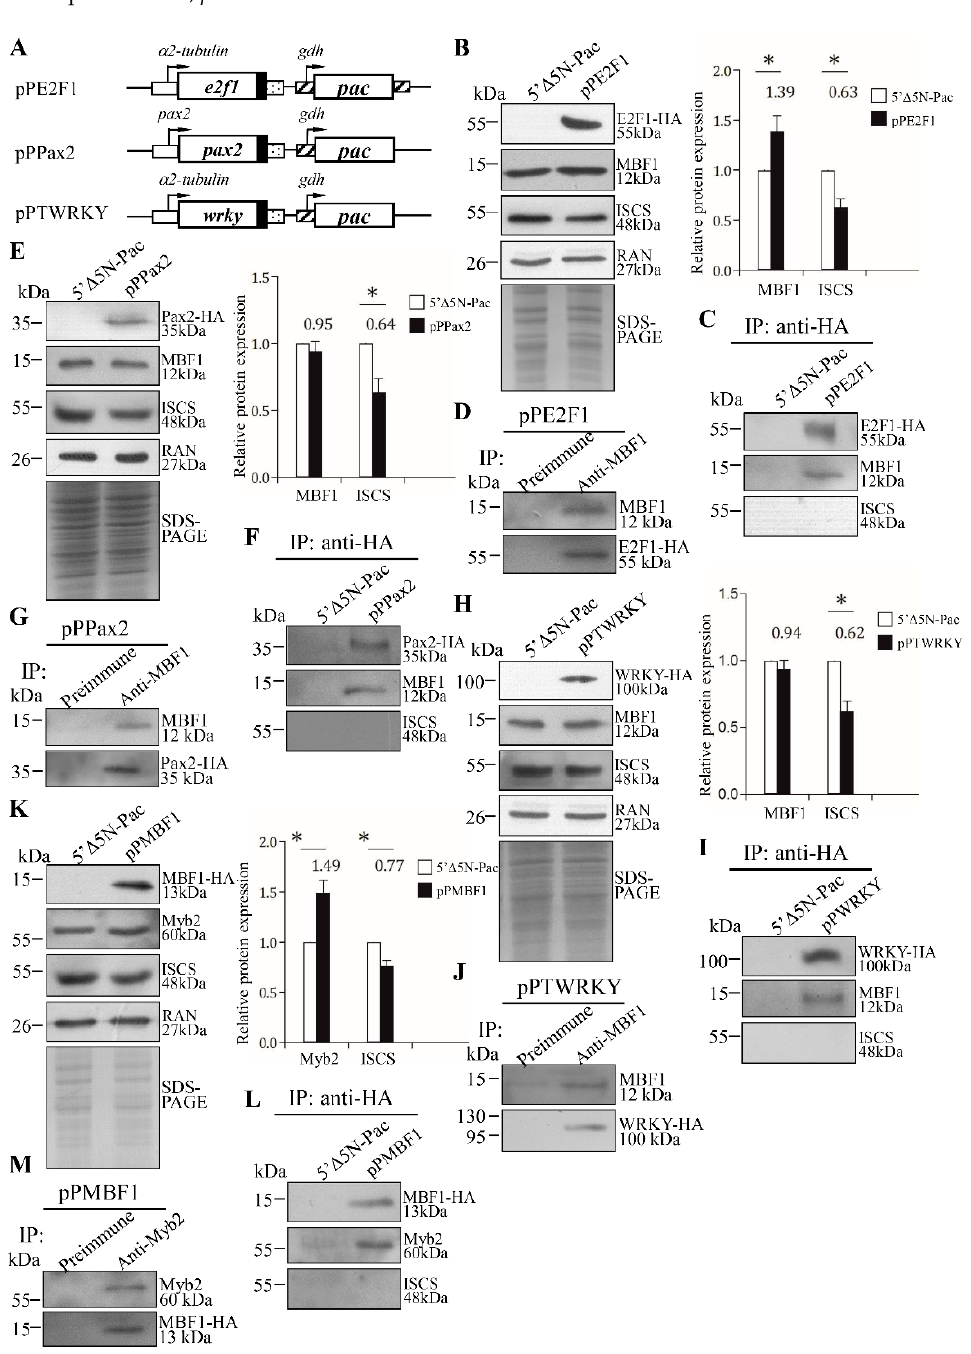
promoter fragments (+), but not the U6 promoter fragment ( − ). The 18S ribosomal RNA gene promoter was used as a negative control ( − ). ( D , E ) ChIP assays coupled with quantitative PCR. Values represented as a percentage of the antibody-enriched chromatin relative to the total input chromatin (% of Input). Results are expressed as the mean ± 95% confidence intervals of at least three experiments. *, p < 0.05.